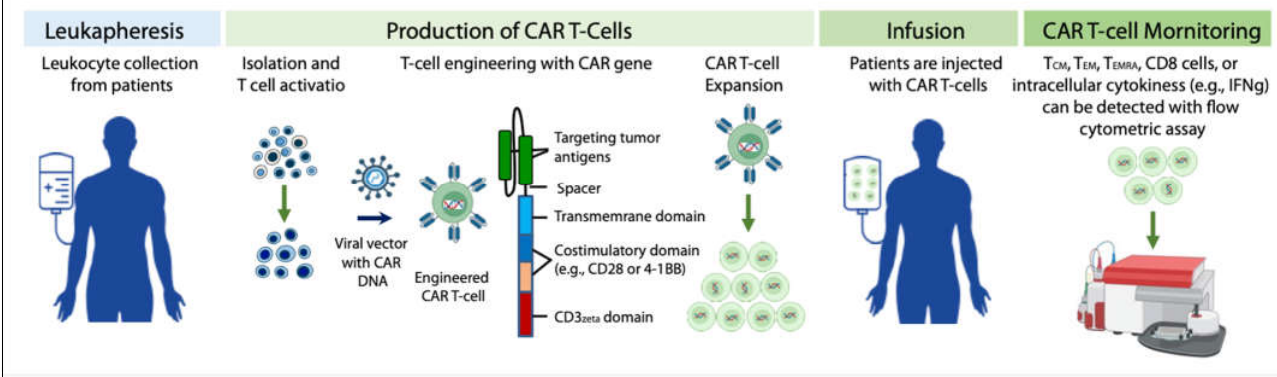
Figure 1. Production, application, and activity monitoring of CAR T-cells.